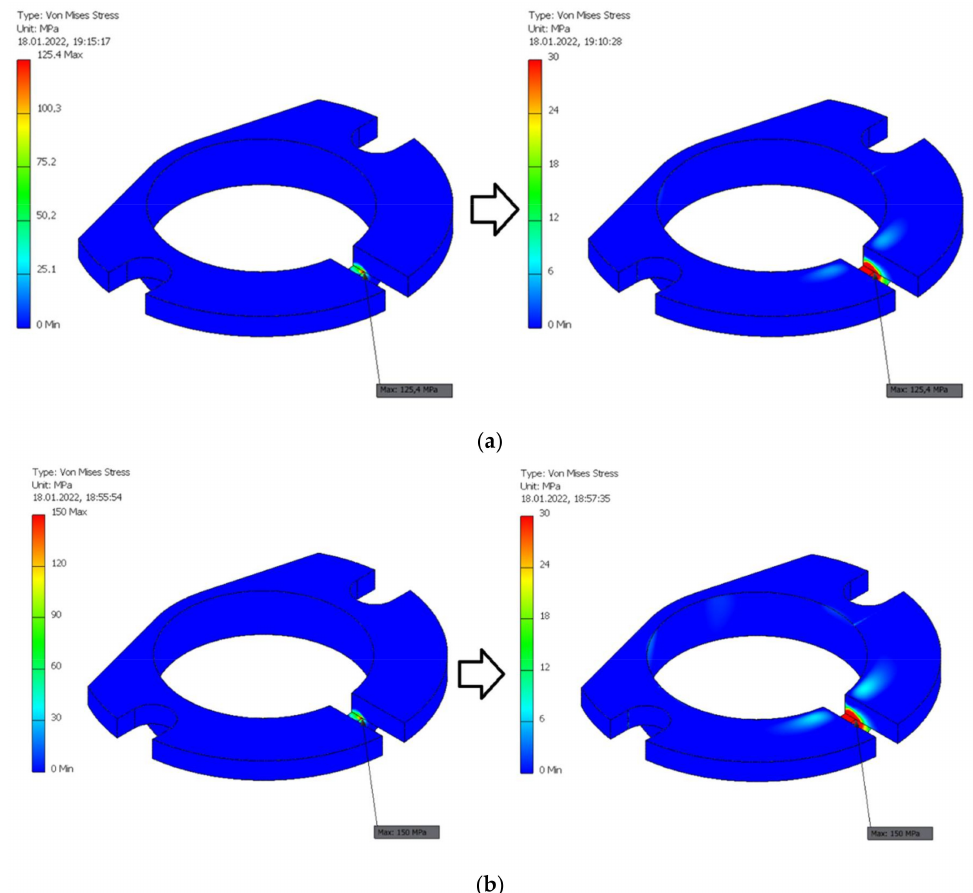
Figure 11. The values of von Mises stresses in the bobbin case milled using various cutters and relative to them, two values of the normal force F n . ( a ) 25.3 N relating to milling with the course cutter ø4; ( b ) 38.2 N relating to milling with the finishing cutter ø5.